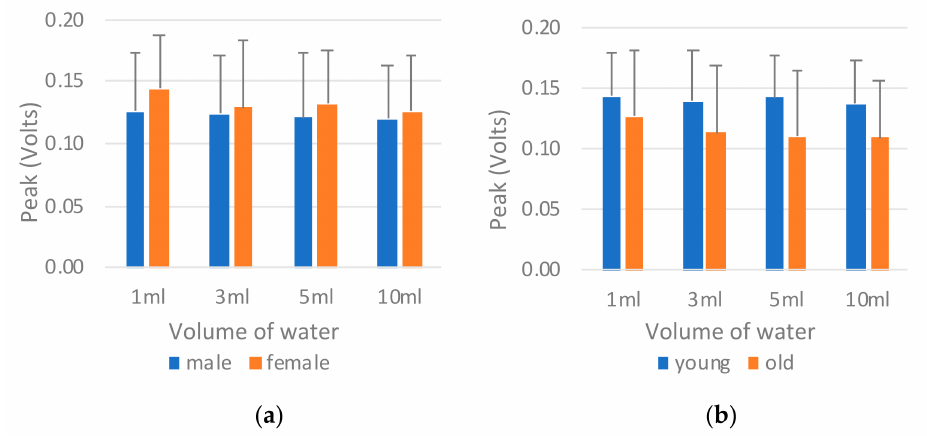
Figure 15. Comparison of tongue pressure peak value ( P tongue ) by ( a ) sex and ( b ) age. Table 11. Analysis of variance (ANOVA) results of tongue pressure peak value ( P tongue